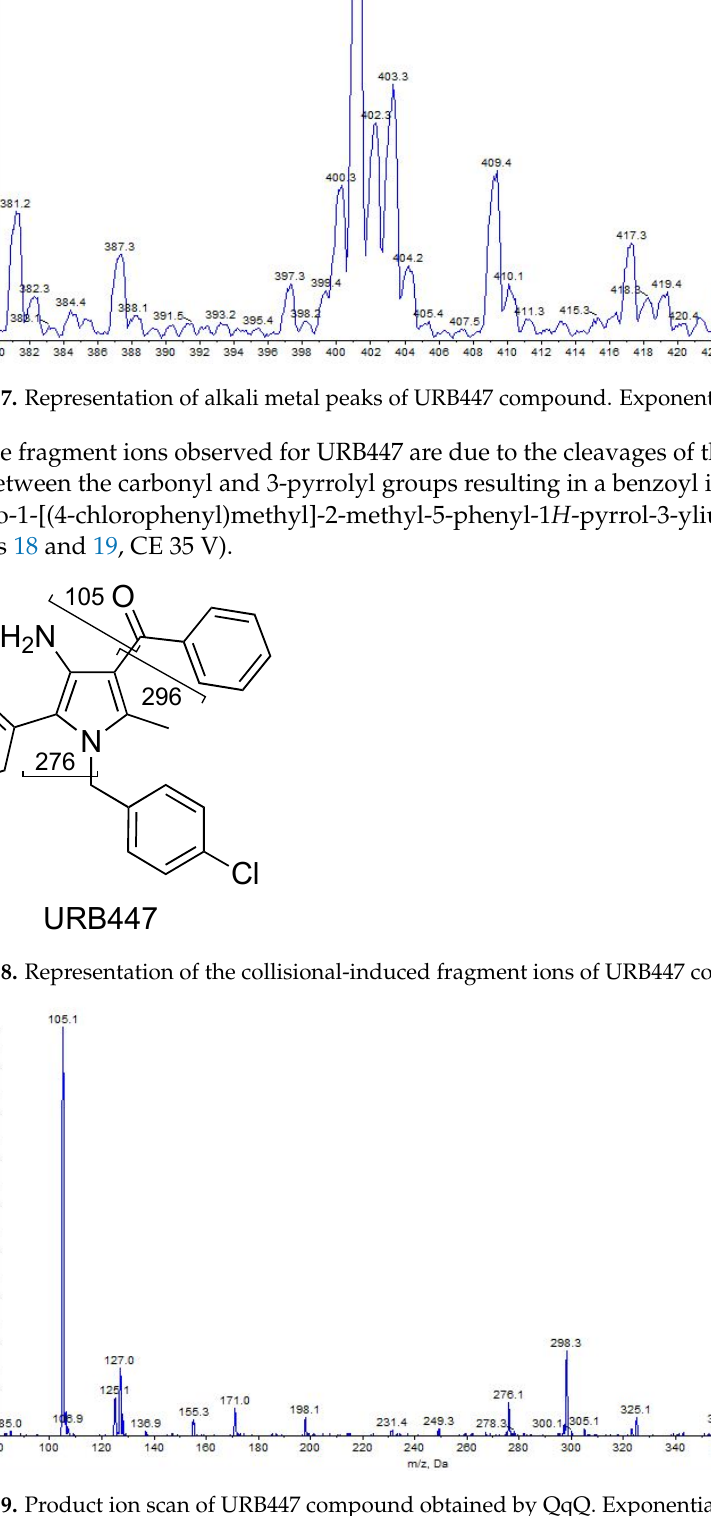
Figure 19. Product ion scan of URB447 compound obtained by QqQ. Exponential scale to base 10. A direct cleavage of the C–N bond between the 4-chlorobenzyl group and the N - pyrrolyl group results in a 4-chlorobenzylium ion at m/z 125 or 4-amino-3-benzoyl-2-methyl- 5-phenyl-1 H -pyrrol-1-ylium ion at m / z 276 (C 18 H 16 N 2 O) (Figures 18 and 19). Analogue fragment ions at m / z 127 and at m / z 298 were observed starting from a similar precursor ion at m/z 403 (figure not shown). The description of the accurate mass is shown in Figure 20. Figure 20 . Product ion scan of URB447 compound obtained by HRMS.